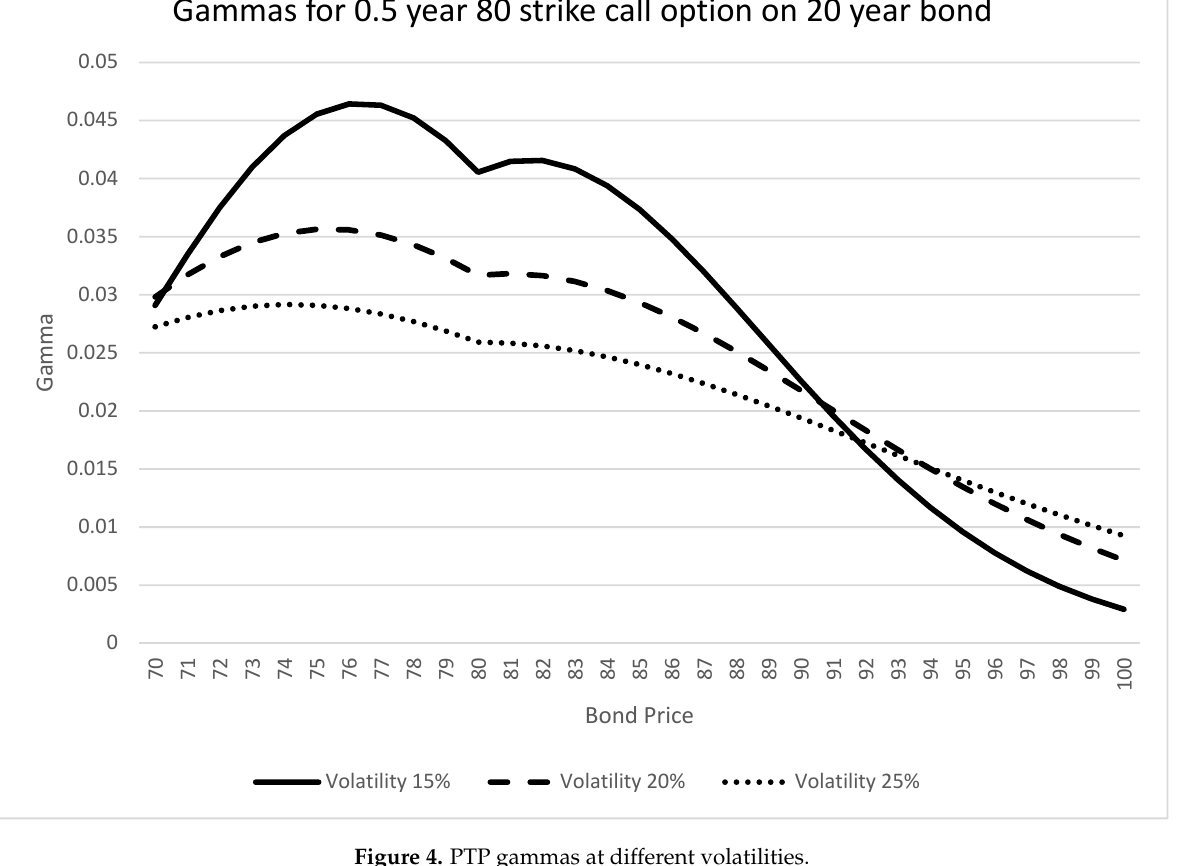
Table 5. Comparison of PTP thetas to Black–Scholes: strike price 80, risk-free rate 0.5%, bond maturity 20 years.